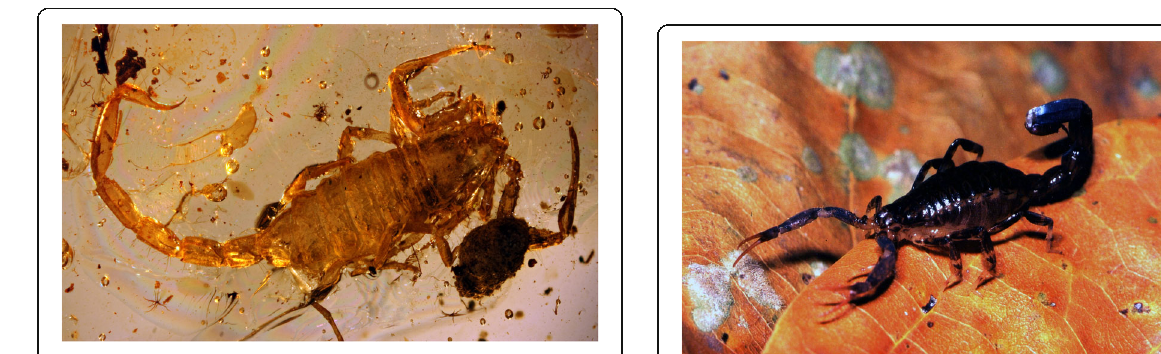
Fig. 8 Betaburmesebuthus bellus Lourenço (Palaeoburmesebuthidae). Young male from Early-Cretaceous amber of Burma (copyright by C. Gröhn, reproduced with permission)